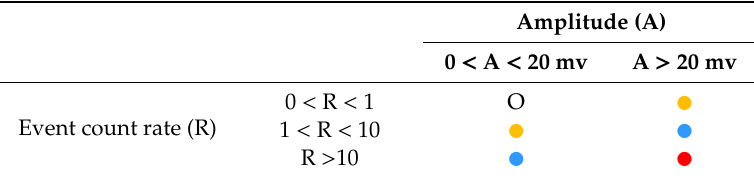
Table 5. Signal strength evaluation standard.